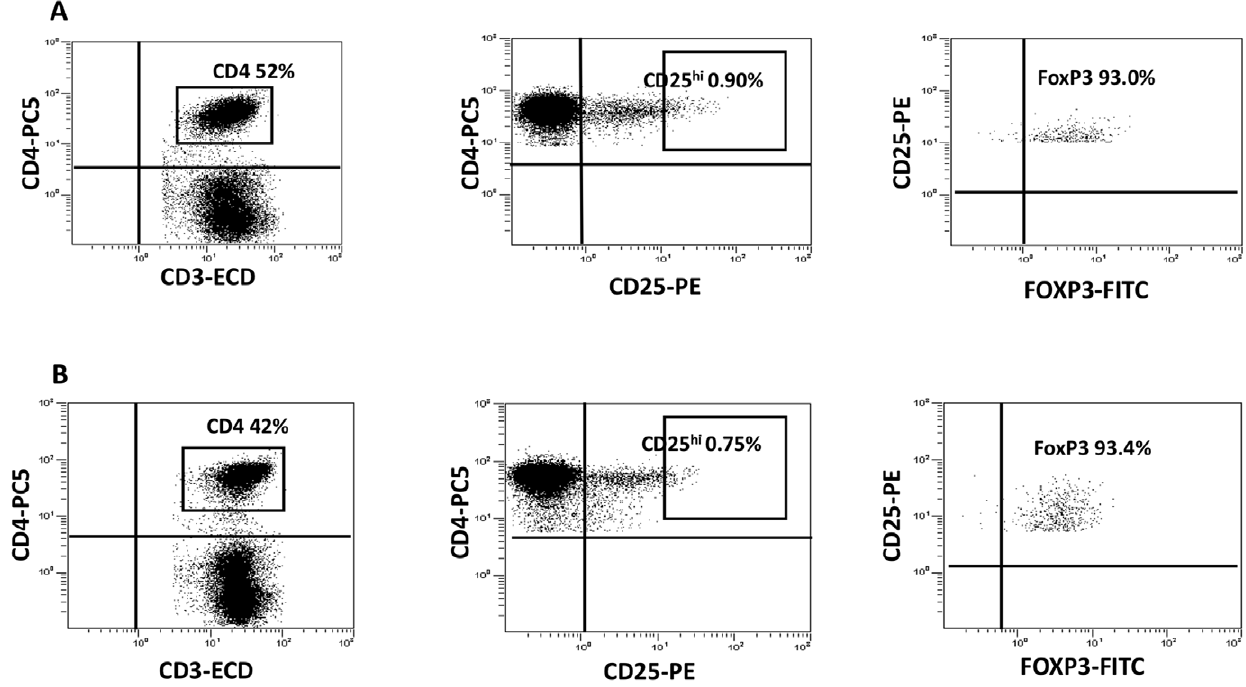
Figure 1. Gating of Treg in representative subjects. Shown above is the gating used to determined the Treg frequency in a representative normal control (A) and an HIV-1-infected subject, pre-vaccine (B). The Treg population was defined as CD3 + CD4 + CD25 HI FOXP3 + .